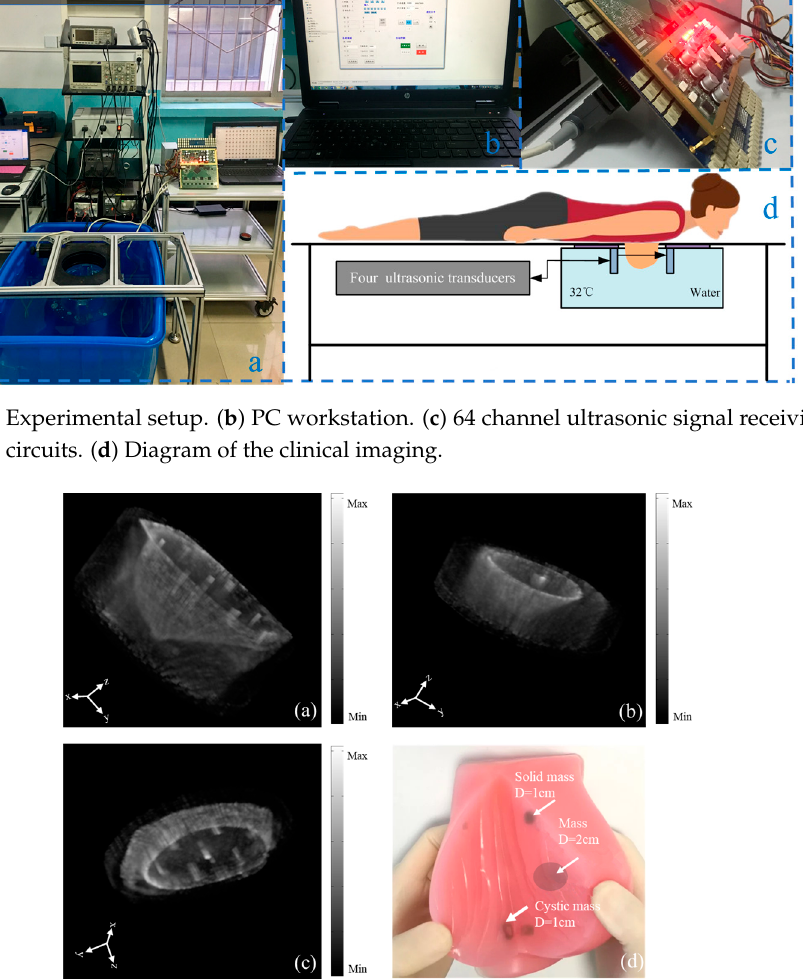
Figure 8. Ultrasonic tomography using this setup. ( a ) The whole breast model imaging. ( b ) The upper part of the breast imaging. ( c ) The lower part of the breast imaging. ( d ) Breast model.